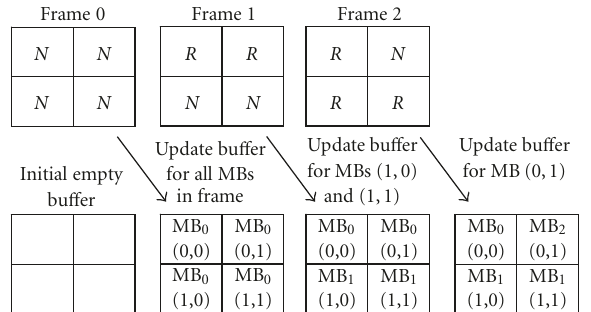
Figure 9: Example of bu ff er updating process used for mode deci- sion based on temporal correlation. N indicates that a new mode decision has been made, while R indicates that the mode decision of the previously coded macroblock is